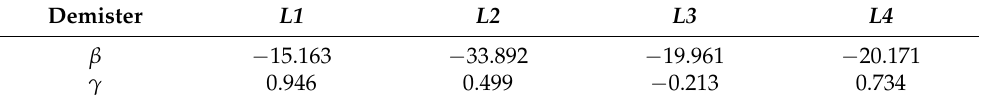
Table 4. Correlation results in separation efficiency under different wavelengths L .